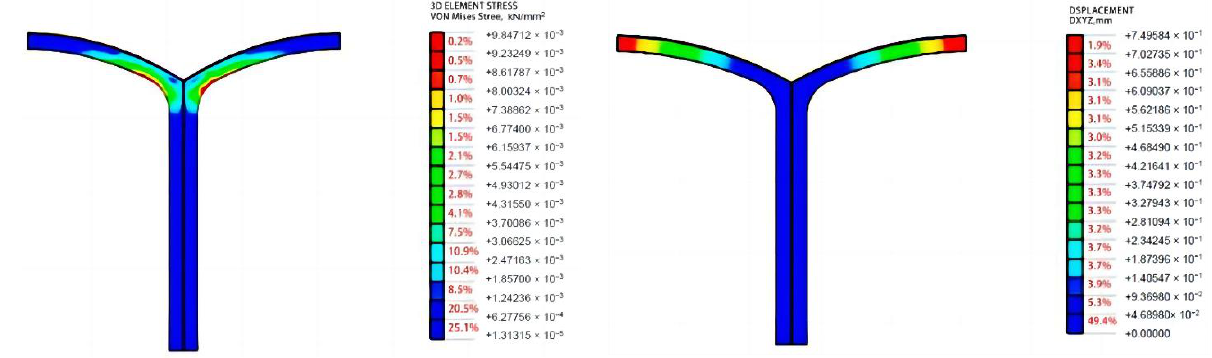
Figure 8. Von Mises stress and deformation contours of the basic unit under vertical loadings.